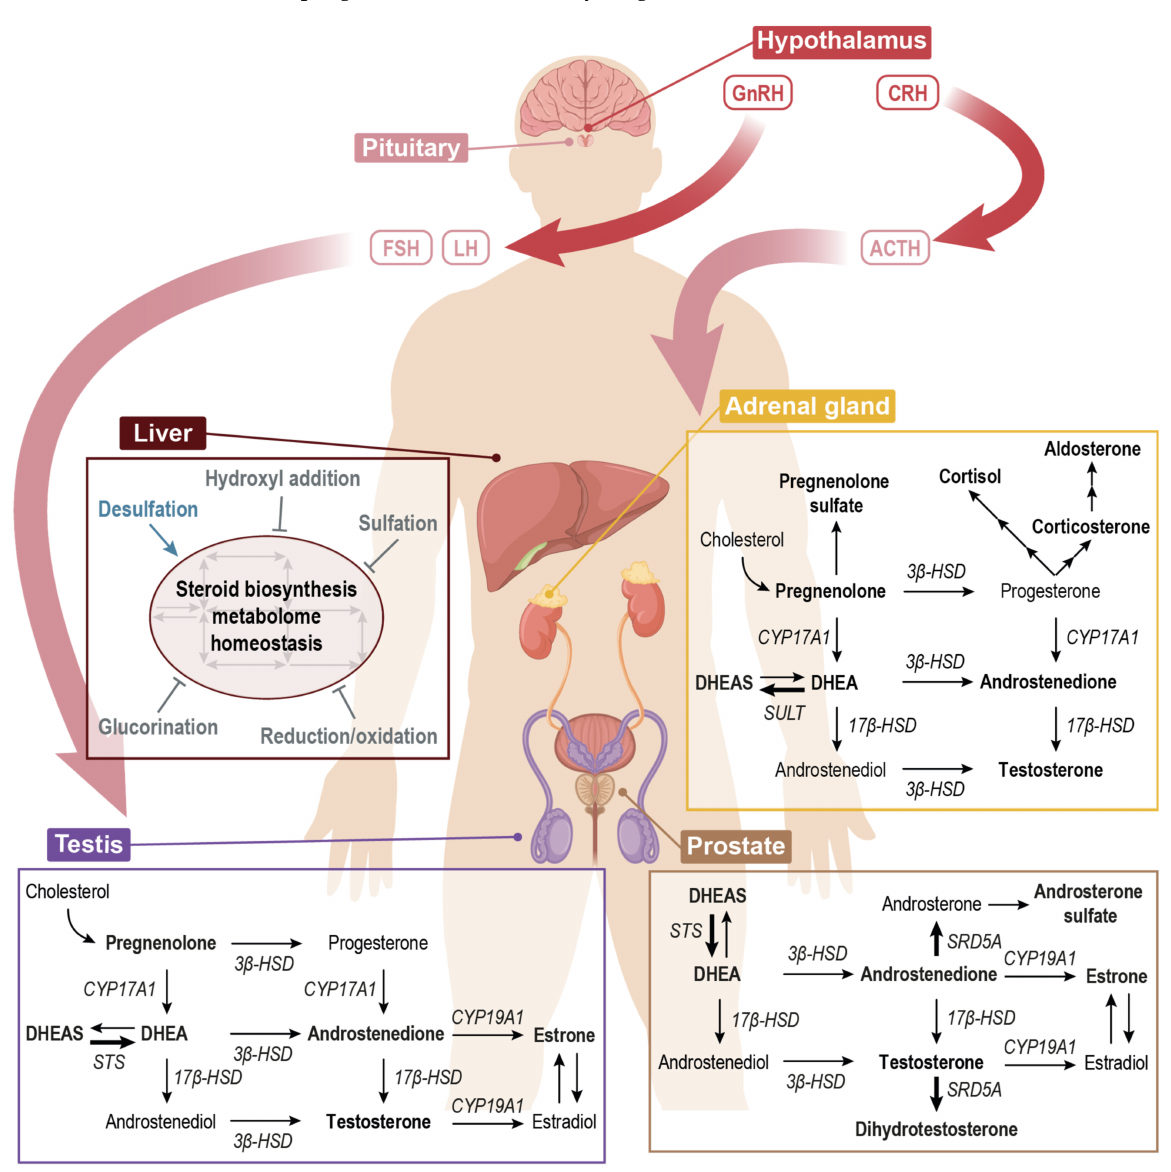
Figure 1. Schematic representation of the steroid hormone biosynthesis pathway in relevant organs and its regulation. CRH stimulates the release of ACTH from the pituitary gland. ACTH stimulates the production of cortisol (exerts negative feedback on CRH and ACTH) and DHEAS in adrenal glands. Pulses of GnRH from hypothalamic neurons stimulate pulses of LH as well as FSH. LH stim- ulates testosterone production in testis. Liver maintains pathway’s homeostasis and several processes may happen: sulf desulfation makes metabolites available to feed the pathway while processes indi- cated with a flat end arrow inactivate metabolites that are in circulation. Bold arrows indicate a higher activity of the specific reaction. In bold, the metabolites that are majorly produced in each specific or- gan are represented. ACTH: adrenocorticotropin; CRH: corticotropin-releasing hormone; FSH: follicle stimulating hormone; GnRH: gonadotropin-releasing hormone; LH: luteinizing hormone;